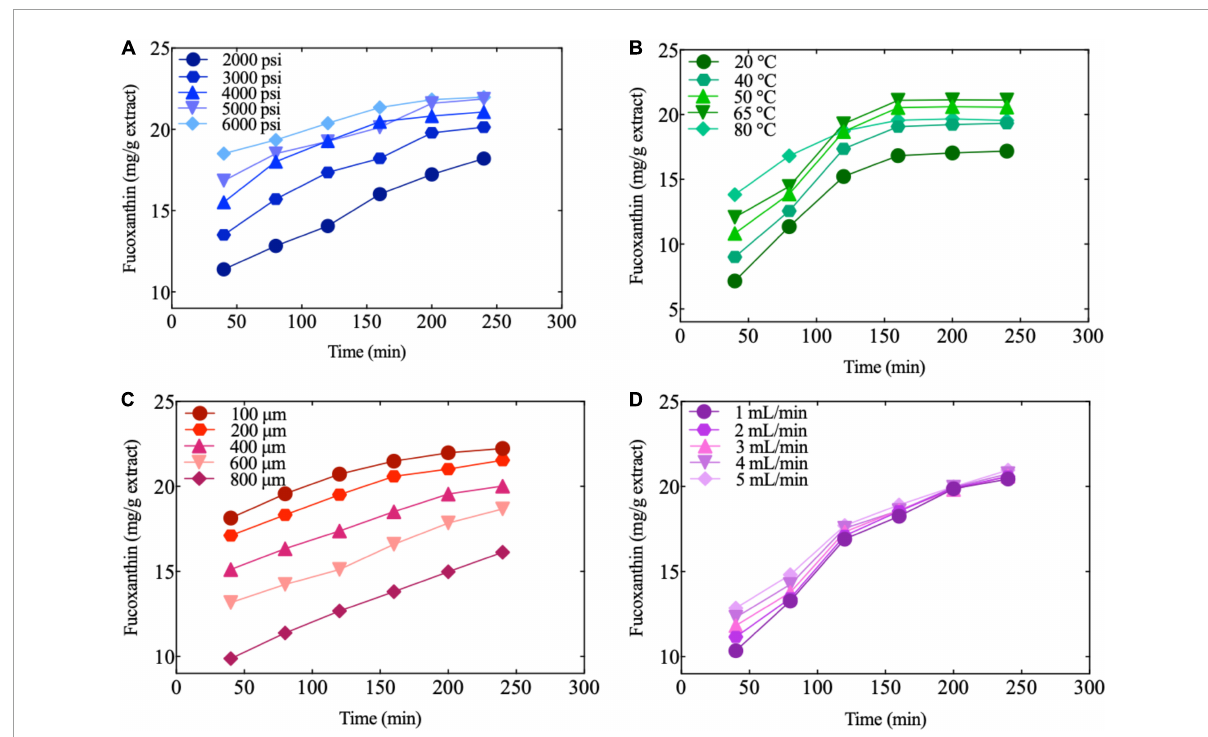
FIGURE4 Fucoxanthin extraction by different conditions. (A) Effect of pressure on the amount of fucoxanthin produced as a function of time at constant extraction temperature, sample size, CO 2 flow, and entrainer (60 ◦ C, 450 µ m, 2.5 ml/min, and 1.25 ml); (B) Effect of temperature on the amount of fucoxanthin produced as a function of time at constant extraction pressure, sample size, CO 2 flow, and entrainer (4000 psi, 450 µ m, 2.5 ml/min, and 1.25 ml); (C) Effect of sample size on the amount of fucoxanthin produced as a function of time at constant extraction pressure, temperature, CO 2 flow, and entrainer (3500 psi, 50 ◦ C, 2.5 ml/min, and 1.25 ml); (D) Effect of CO 2 flow on the amount of fucoxanthin produced as a function of time at constant extraction pressure, temperature, sample size, and entrainer (3500 psi, 50 ◦ C, 400 µ m, and 1.25